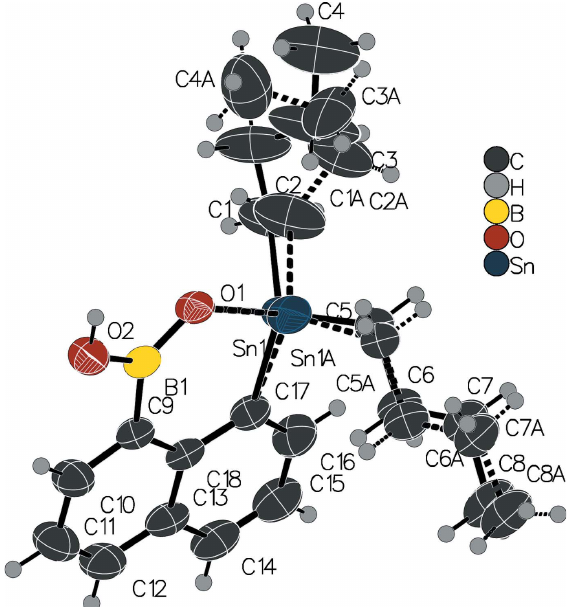
Figure 2 Crystal structure of the title compound 1 . Displacement ellipsoids are drawn at the 50% probability level. Hydrogen atoms are drawn as fixed- size spheres with a radius of 0.15 A˚ . The tin atom and the butyl groups show notable disorder.